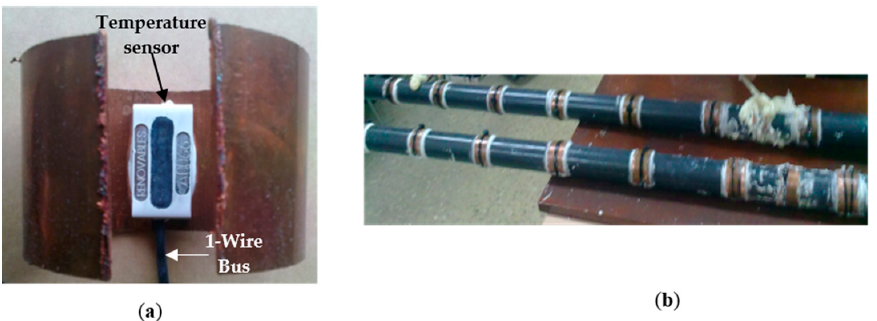
Figure 5. ( a ) Temperature sensor attached to the metal ring; ( b ) GTP disassembled into two sections and arrangement of the sensors on the probe.